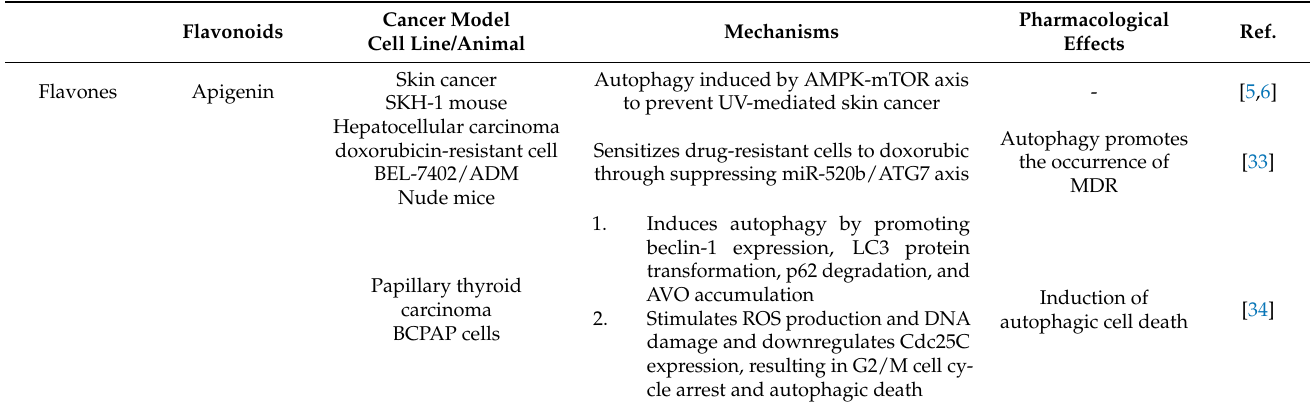
Table 1. Flavonoids in cancers with possible mechanisms discussed in this